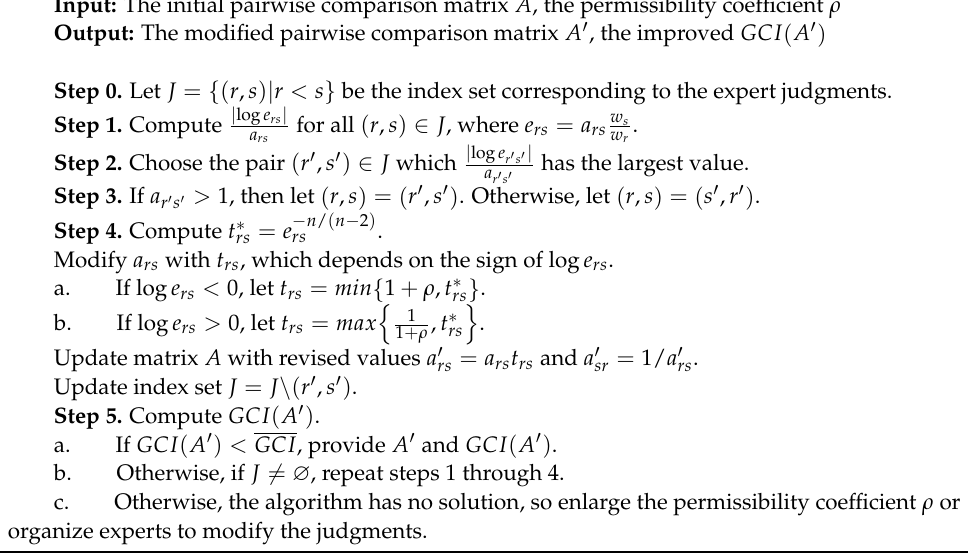
Algorithm 2. GCI -based individual consistency improvement algorithm.